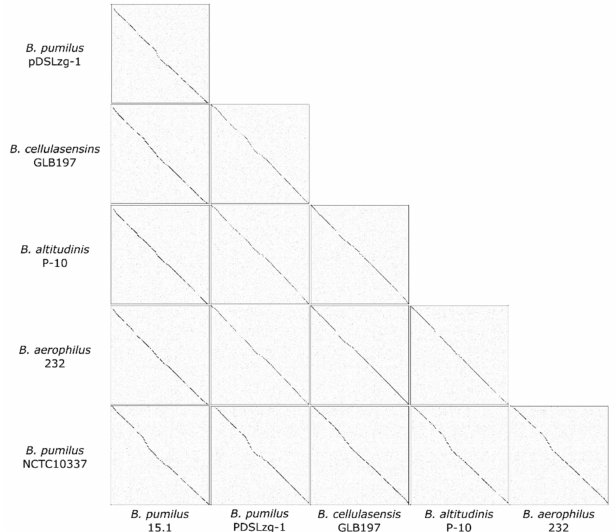
Figure 4. Comparative analysis of the 60.2 Kb region present in B. pumilus related species by dotplot. In B. pumilus 15.1 and B. pumilus NCTC10337 the 60.2 Kb was found inserted in a tRNA-Ala gene, while in B. cellulasensis GLB197, B. altitudinis P-10, B. aerophilus 232 and B. pumilus PDSLzg-1 the insertion was observed in a tRNA-Arg